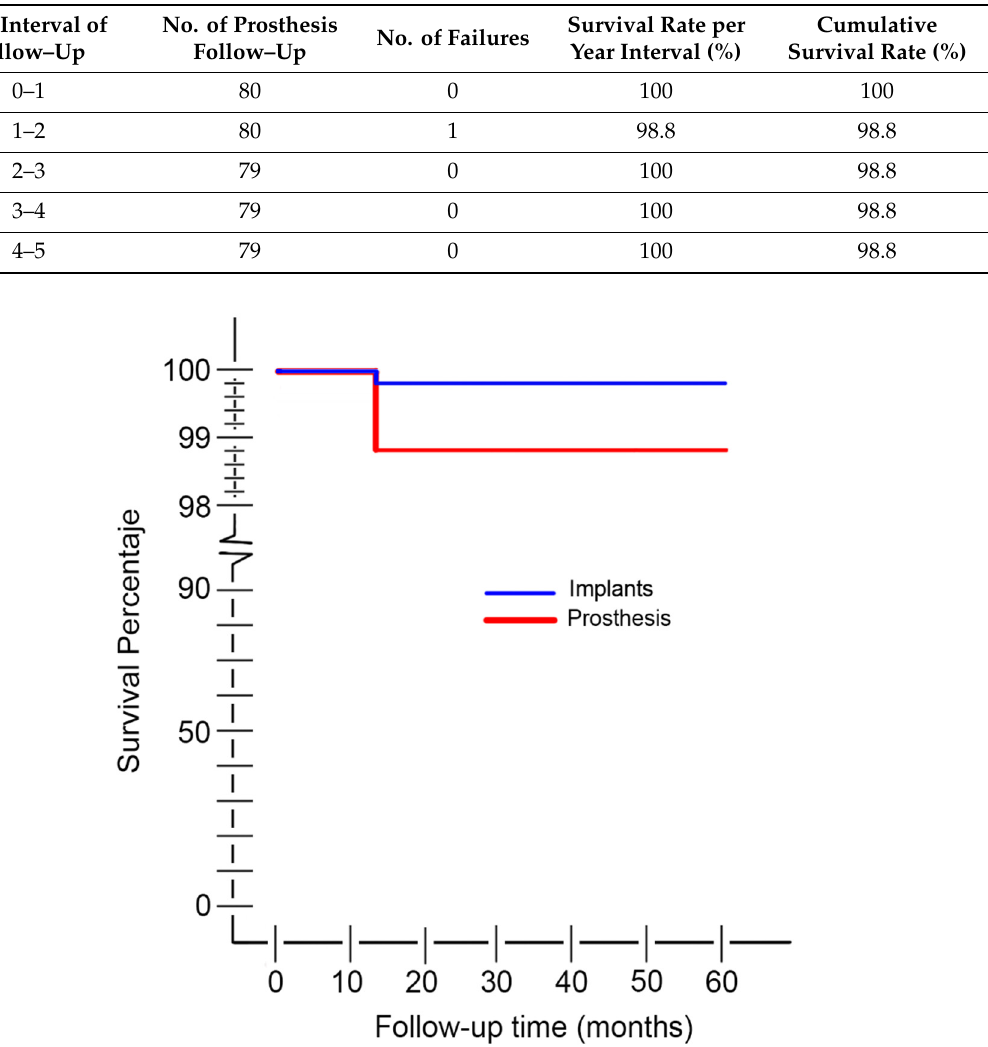
Figure 1. Kaplan-Meier curve for survival estimate of implants and